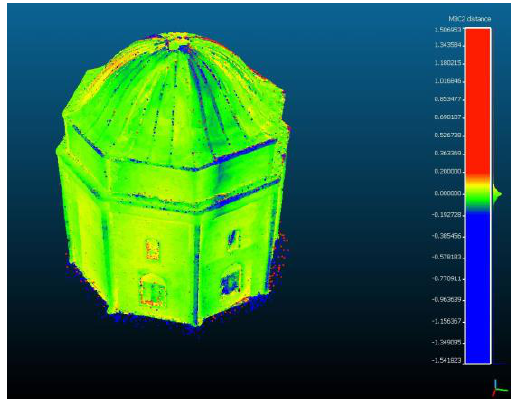
Figure 8: The accuracy of the cloud generated after post- processing the SLAM mesh with respect to the dense cloud of the SfM/MVS